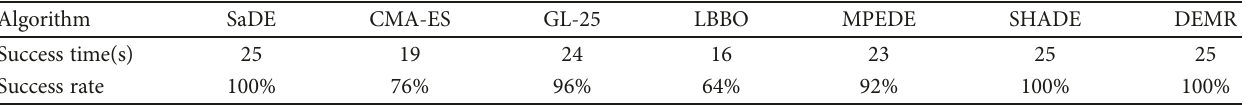
Table 8: Simple investigation of the success rates for all of the algorithms in three-dimensional space.